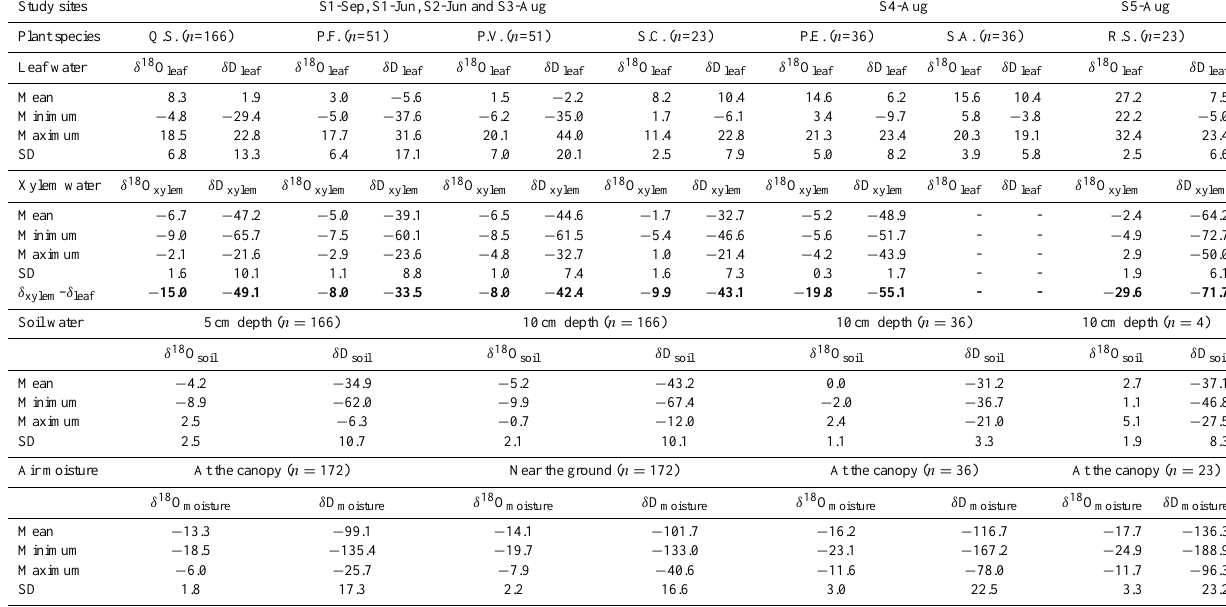
Table 3. Spatial and temporal variations in the δ 18 O and δ D of different water pools in the Heihe River basin. The numbers in parentheses in- dicate the number of samples. In the upper reaches, Q.S., P.F., P.V. and S.C. refer to Qinghai spruce, Potentilla fruticosa , Polygonum viviparum and Stipa capillata in the forest ecosystem. In the lower reaches, P.E. and S.A. refer to Populus euphratica and Sophora alopecuroides in the riparian forest ecosystem. R.S. refers to Reaumuria soongorica at the Gobi site. Study sites Plant species Leaf